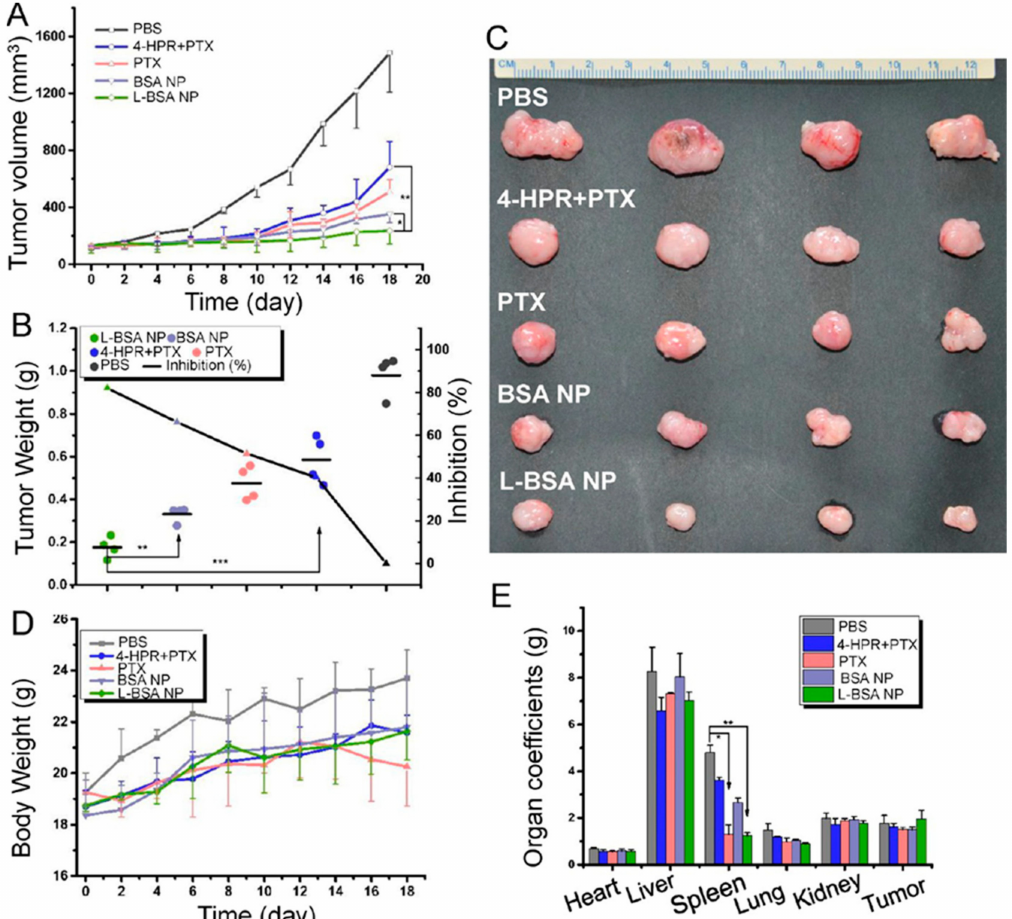
Figure 7. Antiglioma e ffi cacy on the subcutaneous glioma mouse model. ( A ) Tumor growth curve. ( B ) Tumor weight and tumor inhibition rate. ( C ) Representative tumor tissues. ( D ) Bodyweight variations in the treatment course. ( E ) Organ coe ffi cients (* p < 0.05, ** p < 0.01). Reproduced with permission from [128]. Copyright, 2016,